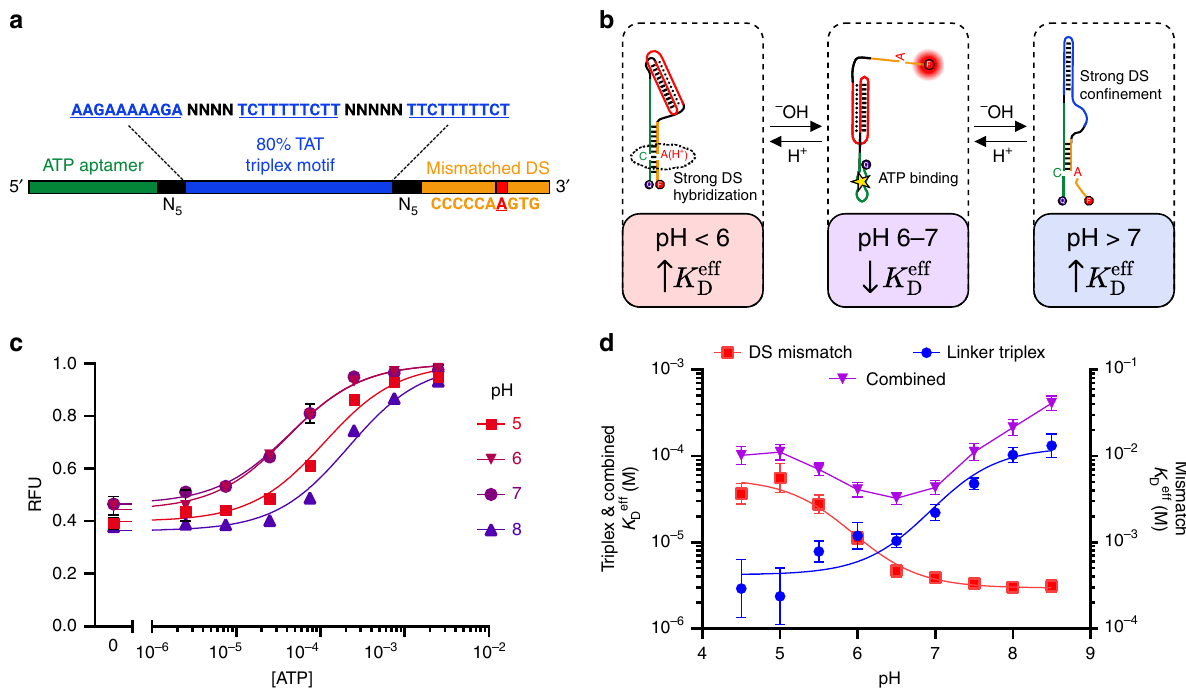
Fig. 4 PSD design for selective binding over a narrow pH window. a We designed a construct that incorporated both an intramolecular triplex in the linker domain and an A – C mismatch in the displacement strand. b Complex pH dependence is achieved through a three-state system, where binding is inhibited by strong DS hybridization at low pH or strong DS con fi nement at high pH, with a small window between these extremes where binding af fi nity is high. c ATP binding curves for the combined construct show the highest af fi nity at pH 6 – 7, with lower af fi nity at both high and low pH. d The pH dependence of af fi nity for this construct ( K eff plotted on left axis) re fl ects contributions from both the binding inhibition of the linker modi fi cation-based TAT80 construct D at high pH (left axis) and the binding inhibition of the DS modi fi cation-based A – C mismatch construct at low pH (right axis). Data points and error bars in c show the means and standard deviations of n = 3 independent experiments. Data points and error bars in d show the best fi t values and standard deviations extracted from Langmuir isotherm fi ts to binding curve data from n = 3 independent experiments (data given in Supplementary Fig. 7) using nonlinear least squares fi tting. Source data are provided as a Source Data fi